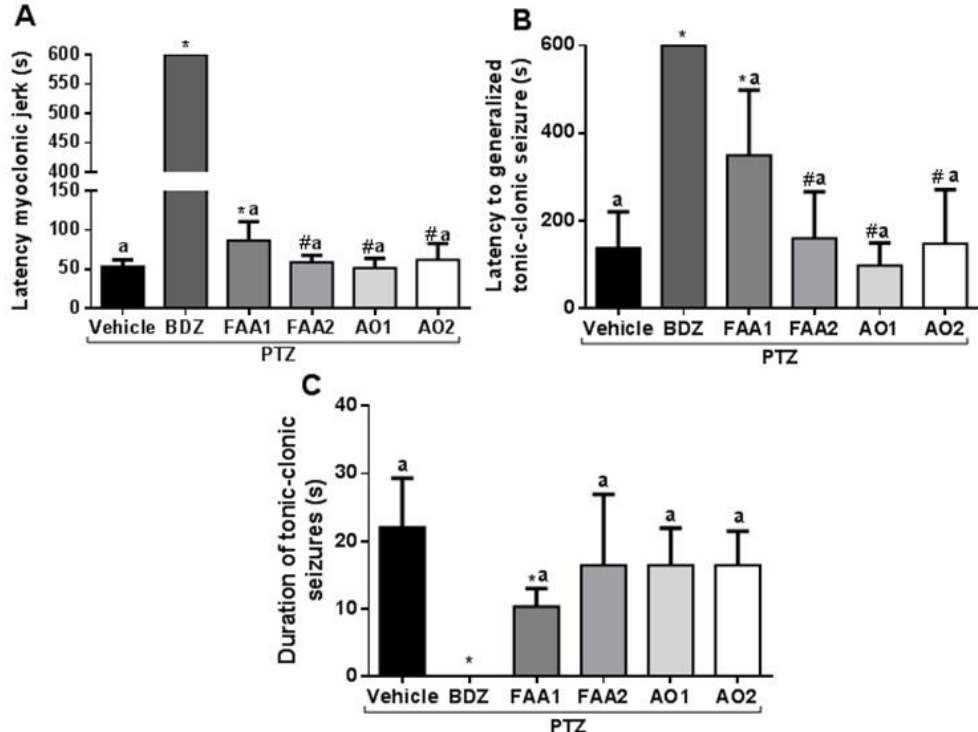
Figure 2. Effects of andiroba oils (AOs = 300 mg/kg) and fatty acid amides (FAAs = 300 mg/kg) on behavioral seizure parameters induced by PTZ (60 mg/kg). ( A ) The latency of the first myoclonic spasm, ( B ) the latency of the tonic-clonic spasm, and ( C ) duration of the tonic-clonic seizures. All results were expressed in seconds (mean ± SD). (*) Statistical difference with vehicle group; (#) difference with FAA1 and (a) difference with benzodiazepine (BDZ) group. Using one-way Analysis of variance-ANOVA, followed by a Tukey test ( p < 0.05).